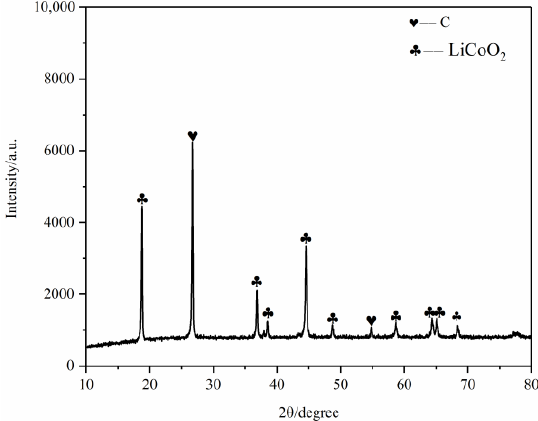
Figure 12. SEM of battery materials after pyrolysis at 200 °C.